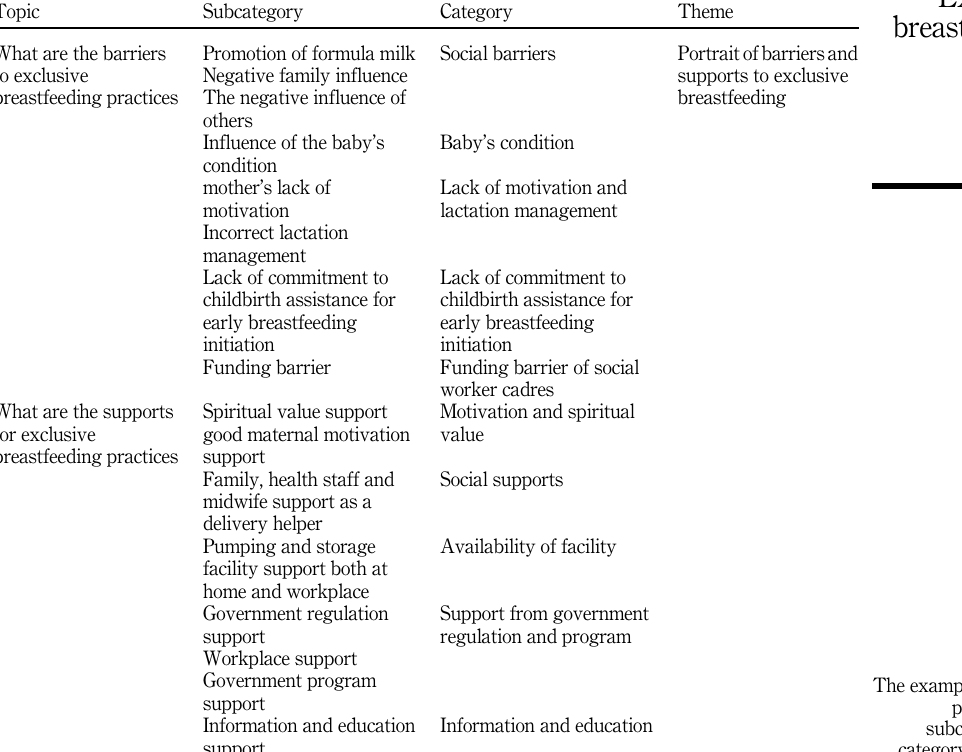
Table 4. The example of